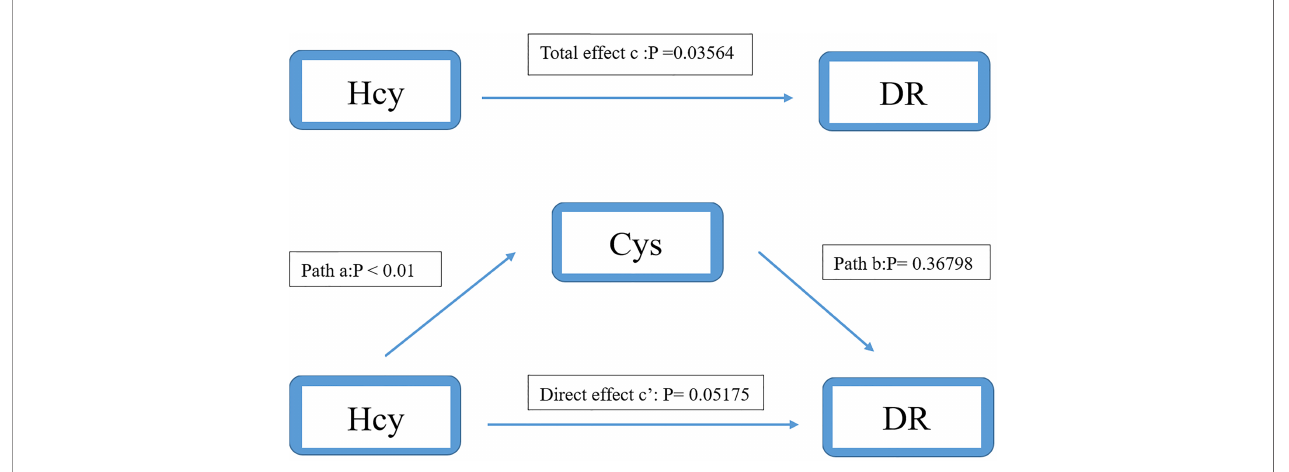
FIGURE 5 | Mediation analysis of the relationship between Hcy and DR by Cys. The mediation analysis adjusted for age, gender, body max index, systolic blood pressure, diastolic blood pressure, low-density lipoprotein cholesterol, high-density lipoprotein cholesterol, triglyceride, glycosylated hemoglobin, urinary creatinine and serum